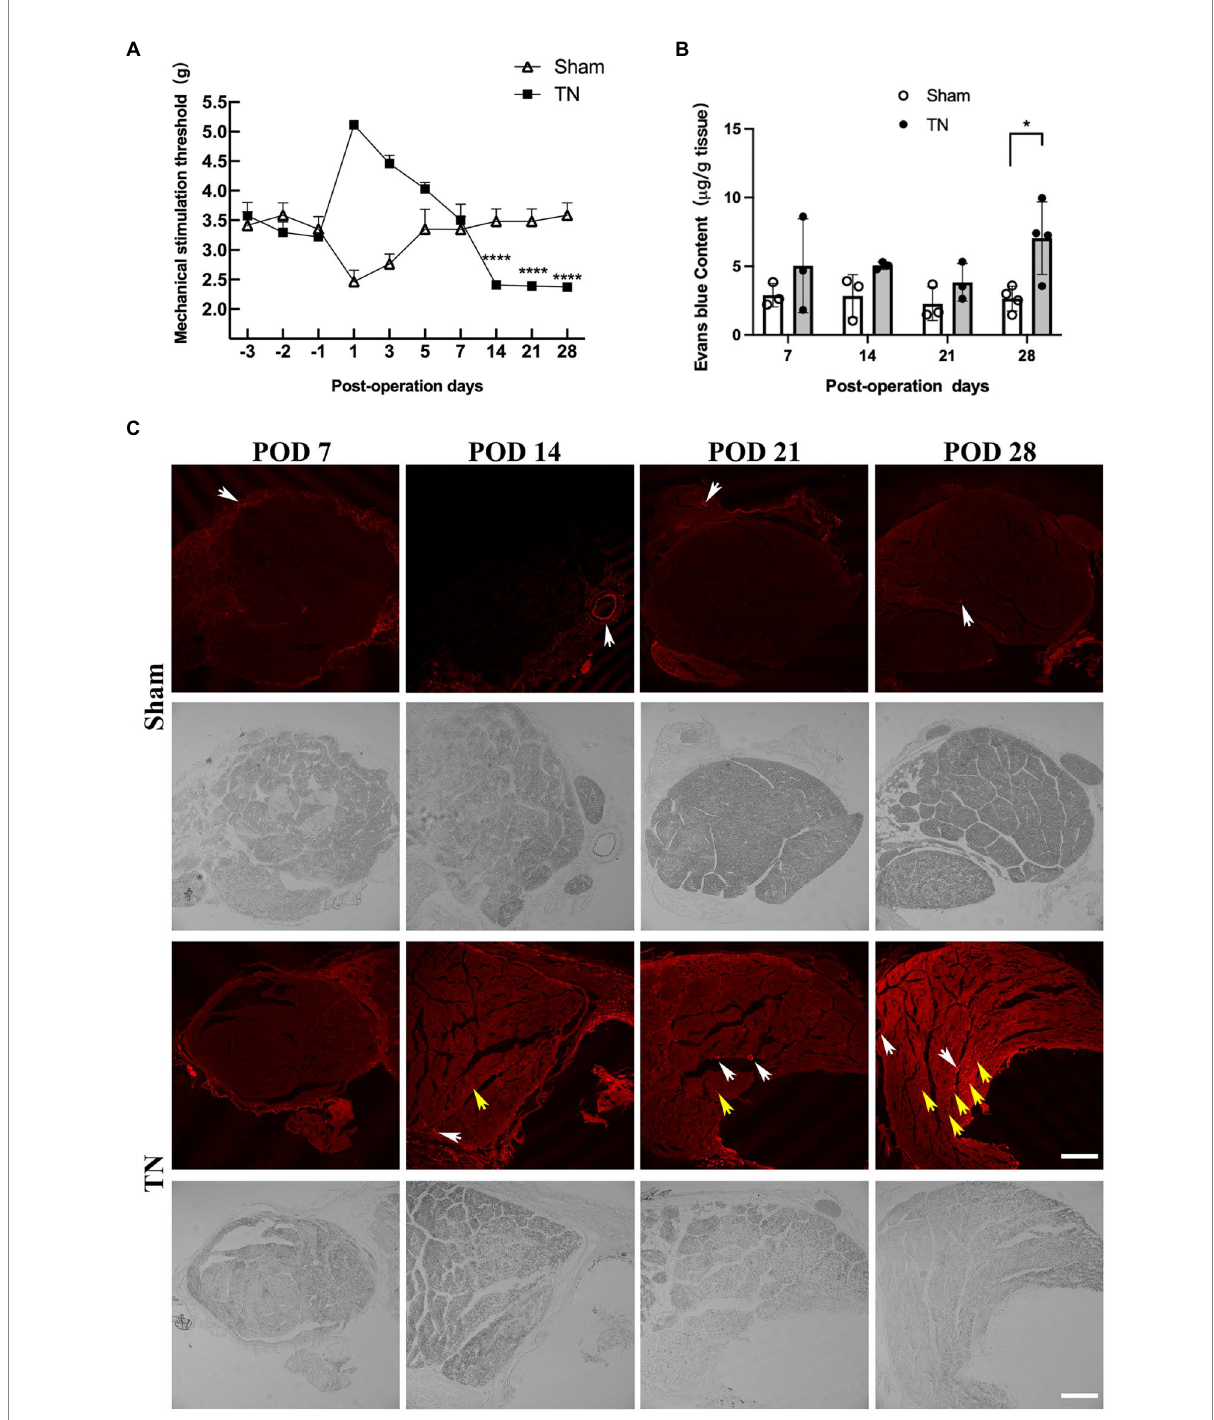
FIGURE 2 Mechanical compression injury of the trigeminal nerve induced orofacial allodynia and disruption of the blood-nerve barrier. (A) Mechanical compression injury of the trigeminal nerve induced changes in the orofacial mechanical stimulation thresholds. Compared with the sham group, TN group rats were insensitive to the mechanical stimulation after TREZ compression injury surgery to POD 7, but they displayed a significant mechanical allodynia according to the withdrawal response of TN rats from POD 14 to 28. (mean ± SD, n = 5, n indicates the number of independent animals; ns: no significant difference, **** p < 0.0001; two-way ANOVA). (B) The content of Evans blue in TREZ tissue was tested in both groups. Compared with the sham group, the content of Evans blue in the TREZ of TN group was significantly increased on POD 28 (mean ± SD, n = 3 or 4/ group, * p < 0.05; two-way ANOVA). (C) The exudation of Evans blue (red) in the TREZ in the sham group and the TN group was observed with a Leica TCS SP8 X laser confocal microscope, bar = 250 μ